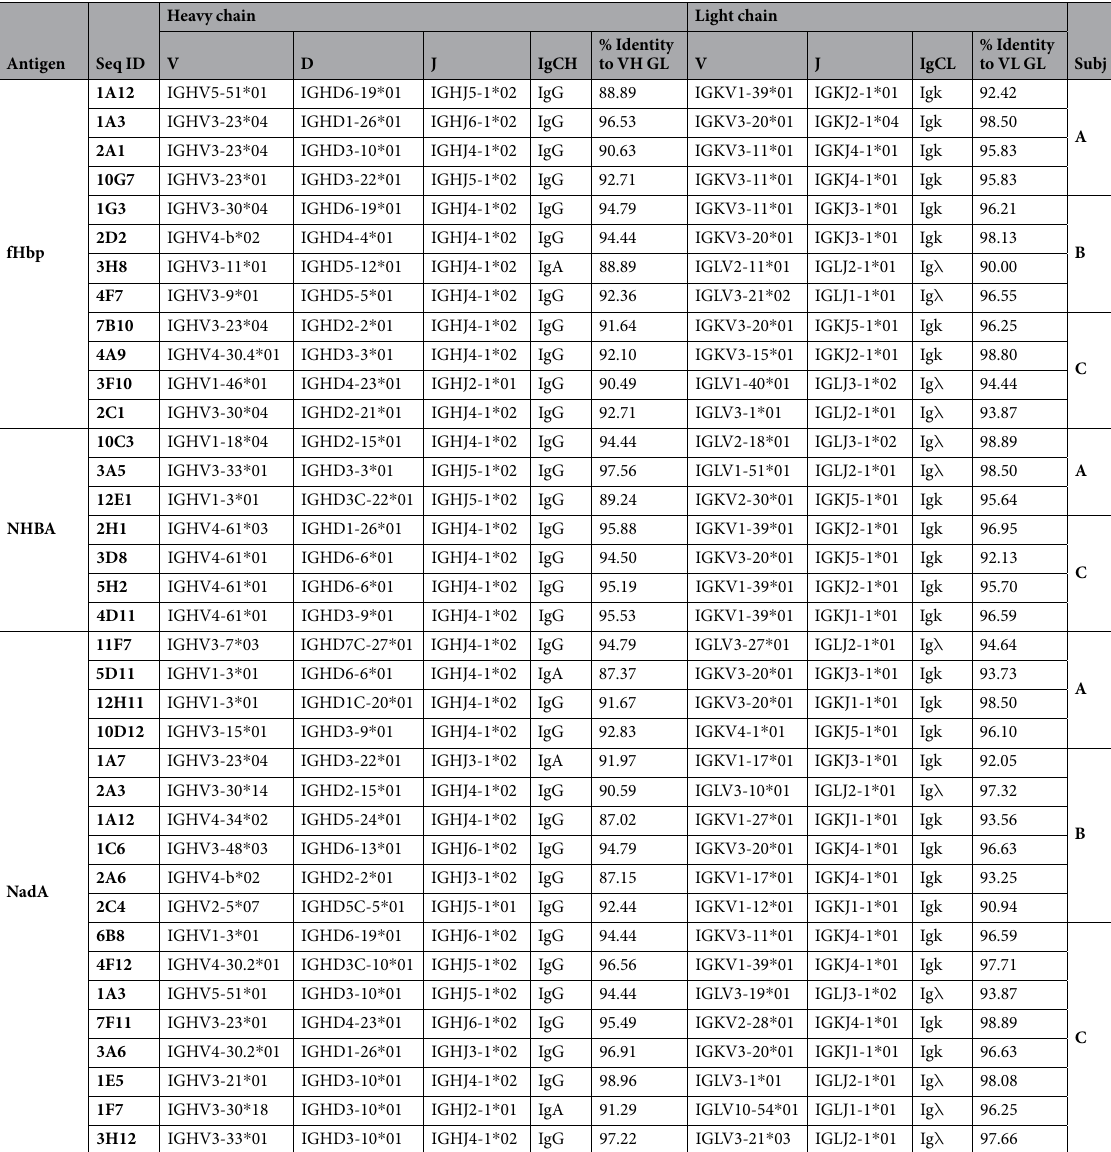
Table 1. Gene usage of monoclonal antibodies isolated against fHbp, NadA and NHBA. The percentage of identity of derived nucleotide sequence to the inferred germline (GL) alleles for VH (V, D, J) and VL (V, J) chains is indicated for each antibody (SeqID). The alleles are reported according to the IMGT nomenclature (ref. 50 , www.imgt.org). Heavy (IgCH) and light (IgCL) chain isotype and the subject from whom the plasmablasts were isolated (Subj) are also